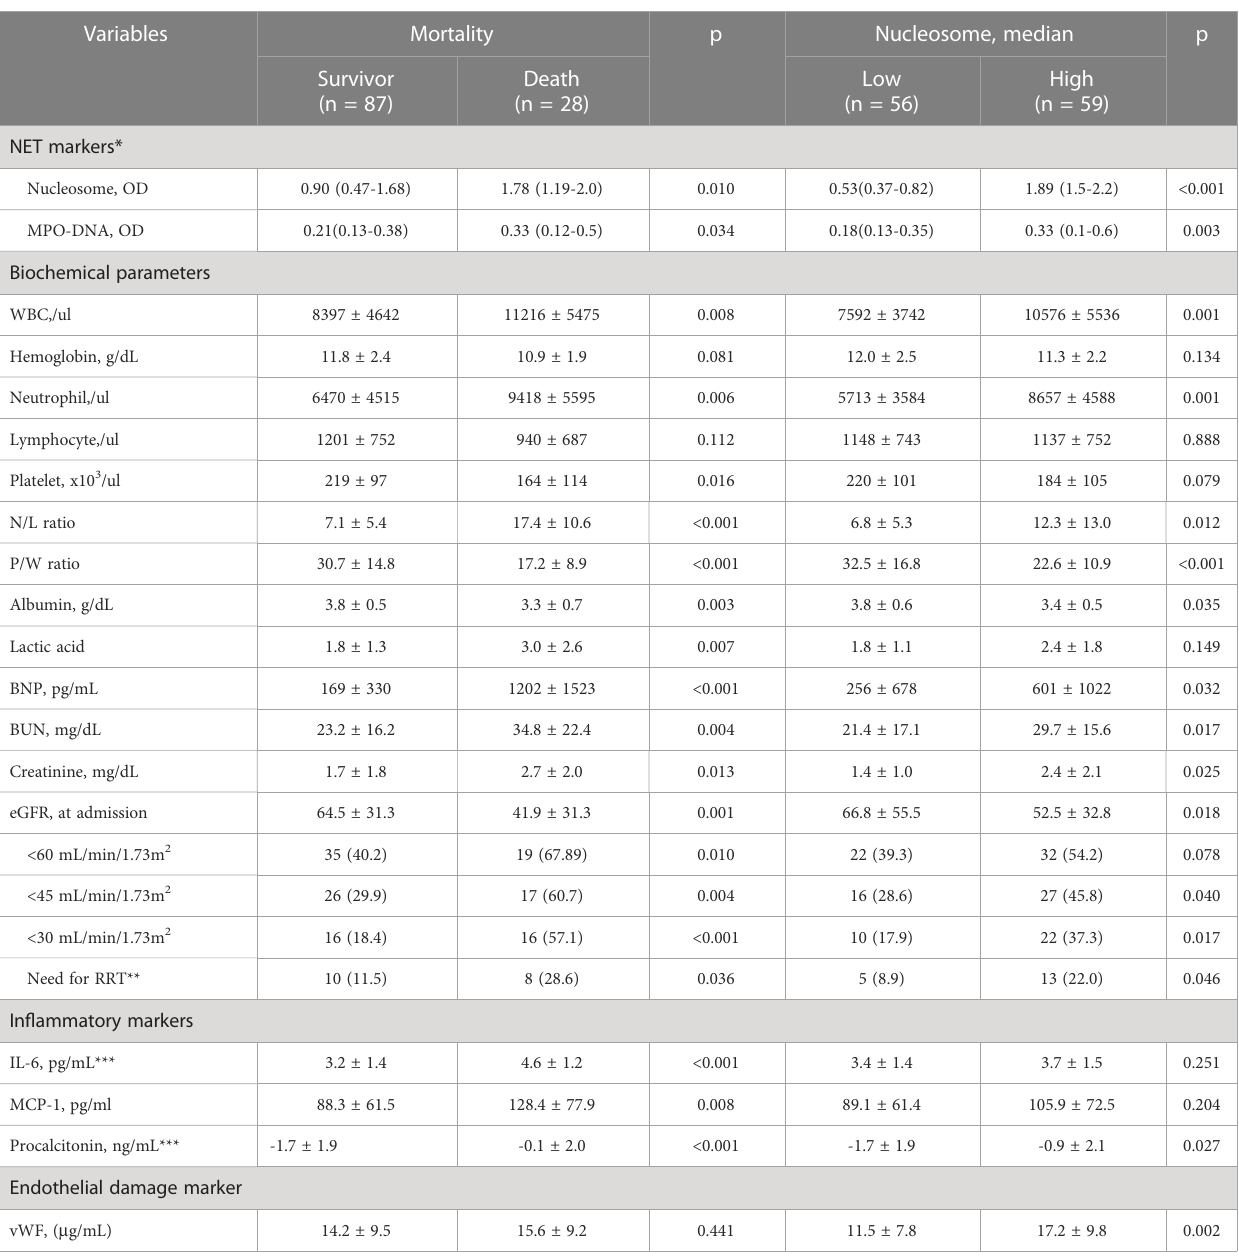
TABLE 2 Biochemical parameters by median NET level and